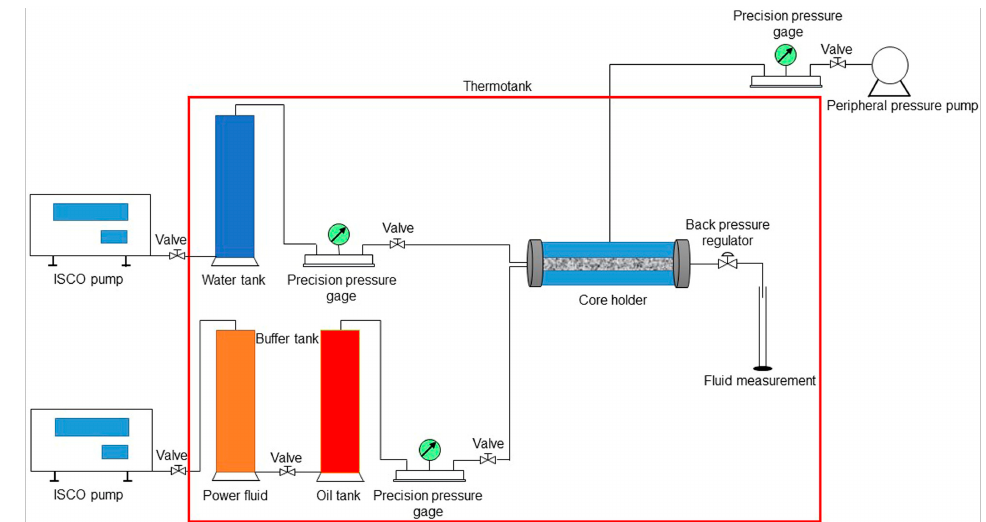
Figure 4. The schematic of the heavy oil flow experiment.